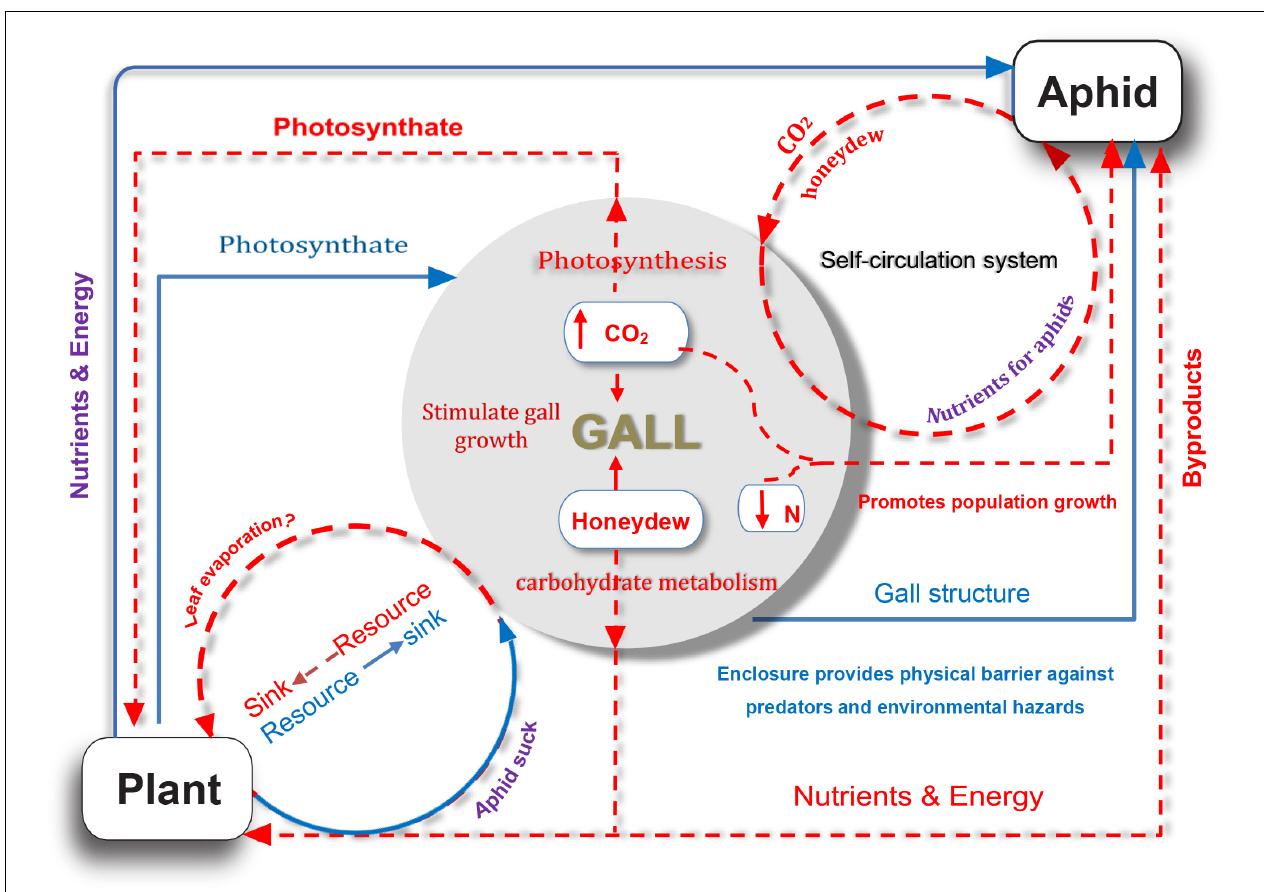
FIGURE 6 | A model for nutrient exchange between host plant and gall-forming aphid colony. Solid blue lines represent that the host plant is beneficial for aphid; dotted orange red lines indicate potential indirect benefits from aphid to host plant.